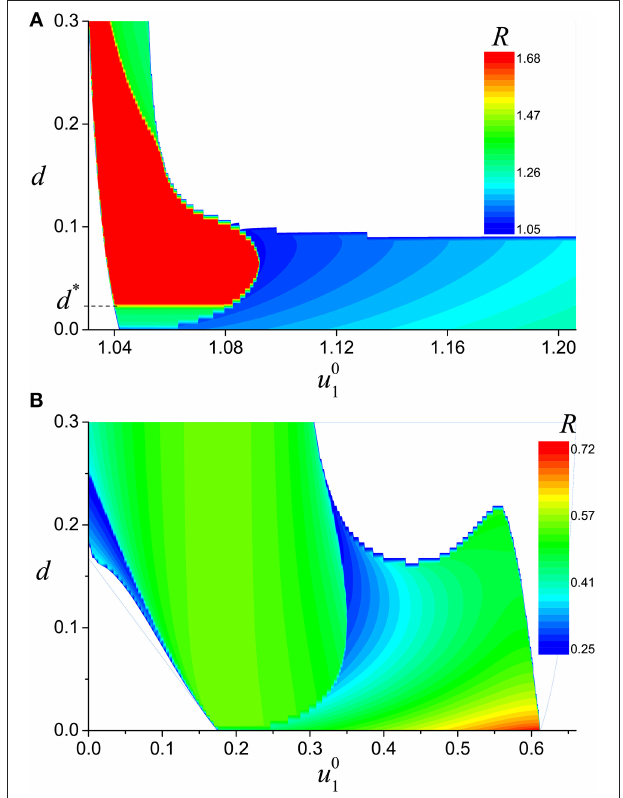
FIGURE 7 | The partition of ( u 0 1 , d ) - parameter plane into areas corresponding to different transitions [along the trajectories of the fast system (7)] from the border of submanifold (A) S a 8 (B) S a 8 . R is the distance from the origin of slow subsystem phase plane ( u 1 , u 2 ) to a next stable submanifold. The red color in (A) marks the region where the next manifold is S a 13 . Non-white colors in (B) mark the region where the next manifold is only one of S a 6 , S a 7 , S a 10 , S a 11 . Parameters values: a = 0.32, b = 0.79, c = 1.166, and d = 0.06.